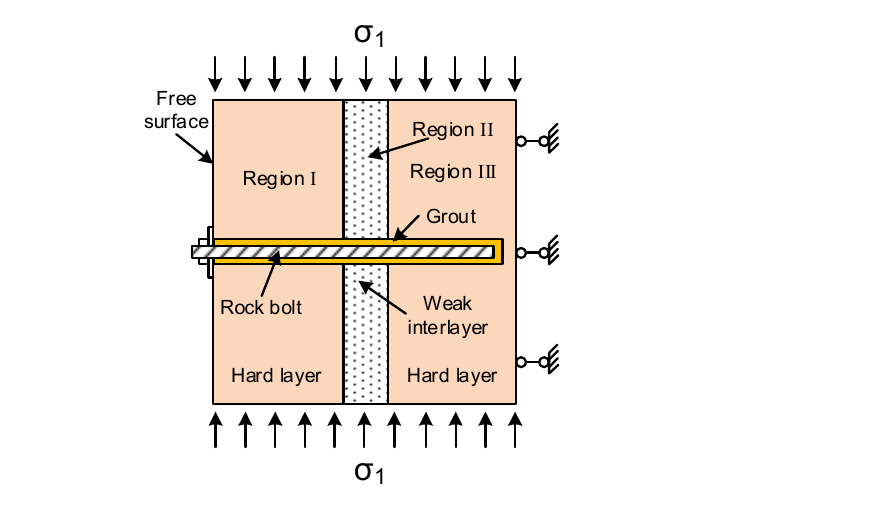
Figure 10. Sketch diagram of region for the specimens containing a weak interlayer.